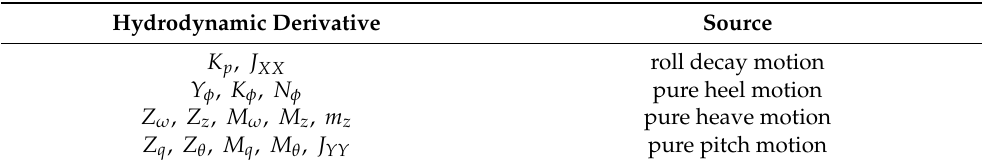
Table 2. The source of the hydrodynamic derivative. Hydrodynamic Derivative